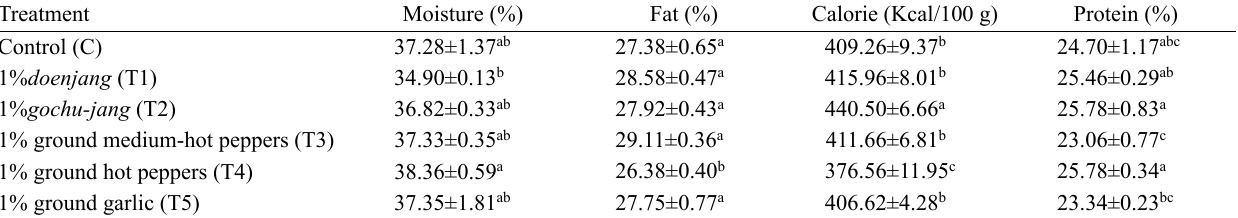
Table 1. Proximate compositions of fermented sausages as affected by the seasonings addition 1